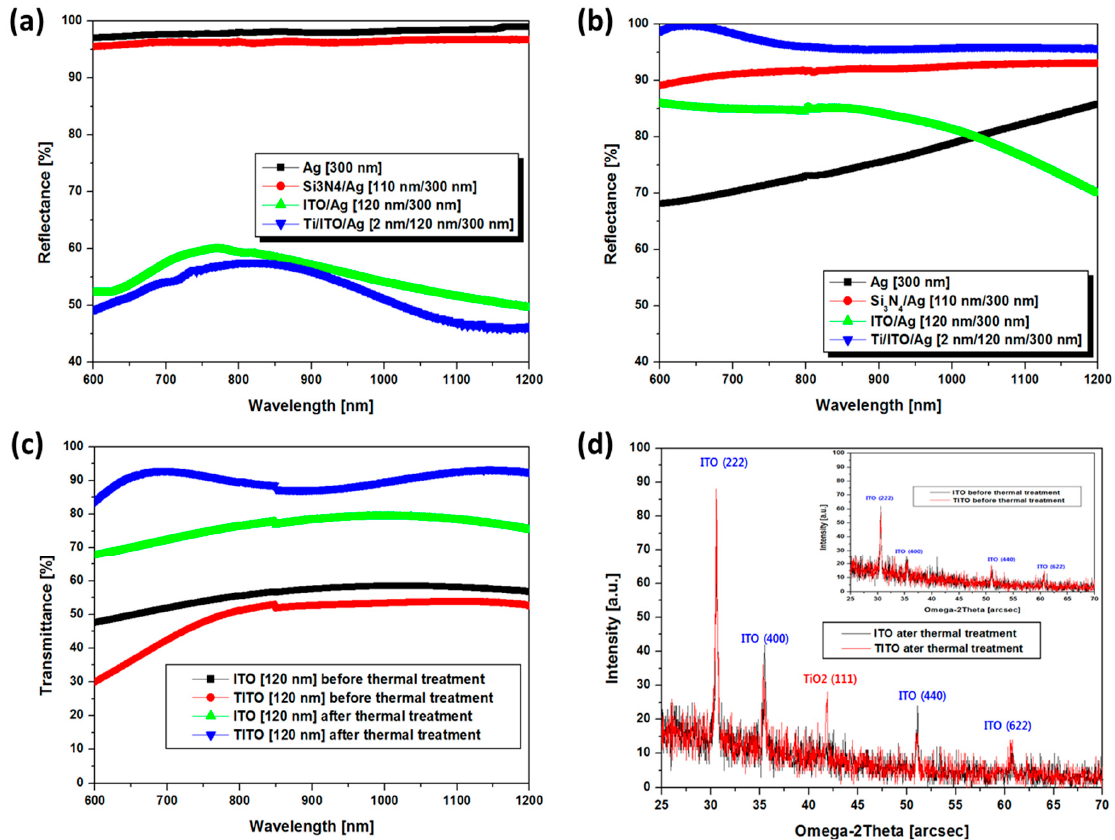
Figure 2. ( a , b ) Reflectance performances of Ag-based single-layer reflector (Ag) and multilayer reflectors (Si 3 N 4 /Ag, ITO/Ag, and TITO/Ag) before and after thermal treatment. ( c ) Optical transmittance and ( d ) X-ray diffraction (XRD) data of ITO and TITO before and after thermal treatment.